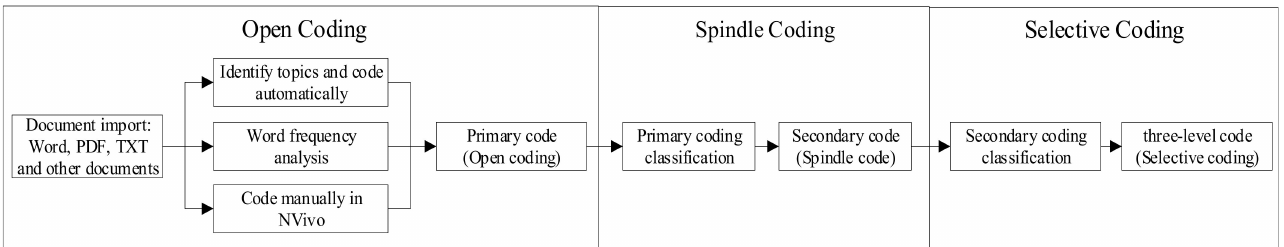
Figure 2. Three-level coding process in